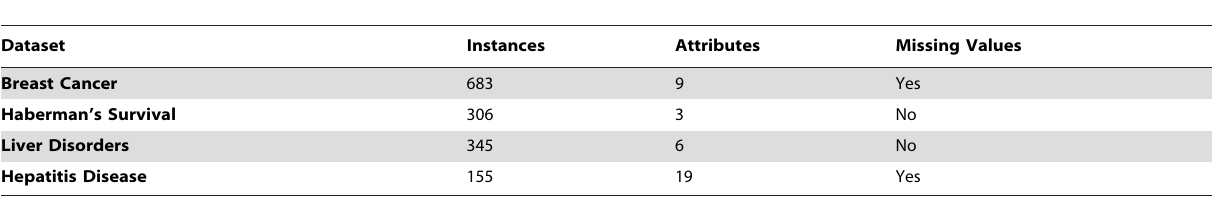
Table 1. Characteristics of the datasets used in the experimetal phase.